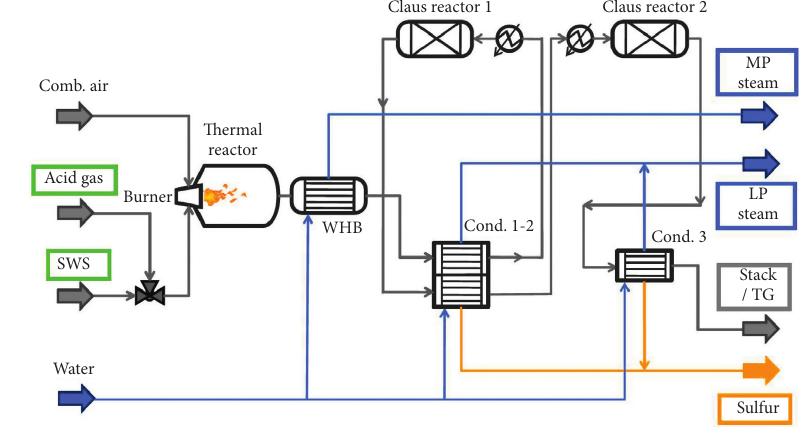
Figure 1: Basic scheme of a sulfur recovery